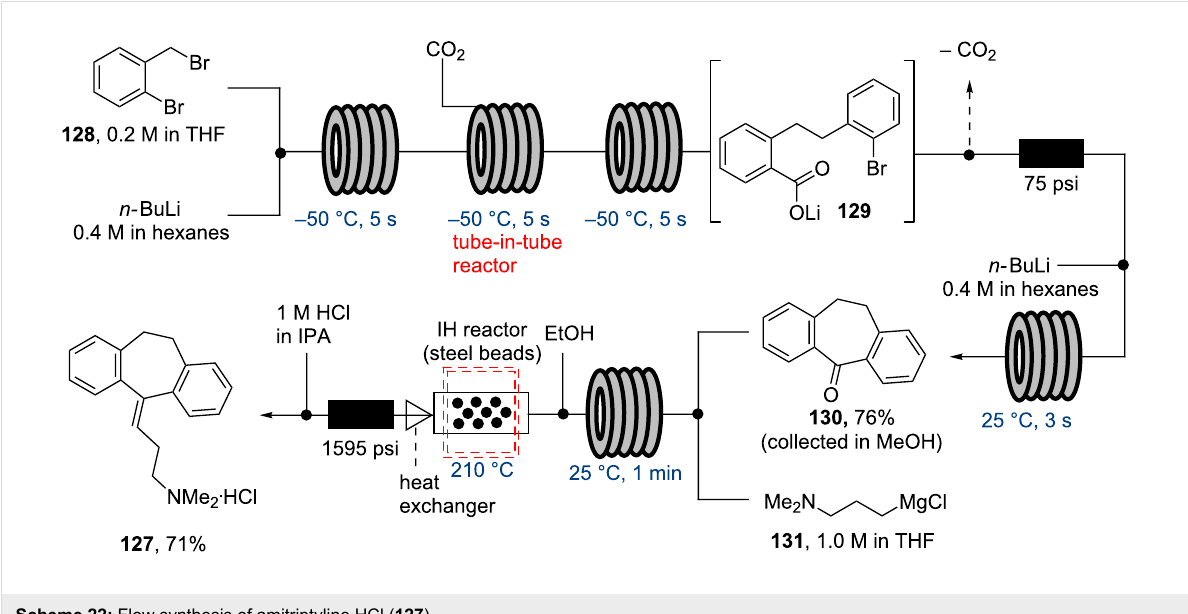
Scheme 22: Flow synthesis of amitriptyline·HCl ( 127